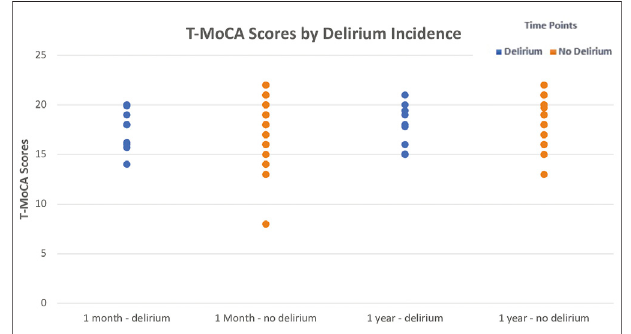
FIGURE 4 | Median ± Interquartile range (IQR) Telephonic- Montreal Cognitive Assessment (T-MoCA) scores by incidence of delirium at 1 month and at 1 year The fi gure displays the differences in median T-MoCA scores betweenthosewithdeliriumandthosewithoutdeliriumatthetwofollow- up time points. While no signi fi cant differences were observed, median T-MoCA scores were slightly higher in the non-delirium group compared to the delirium groupat bothtime points. AWilcoxonRank-Sumtest wasutilized to test this.